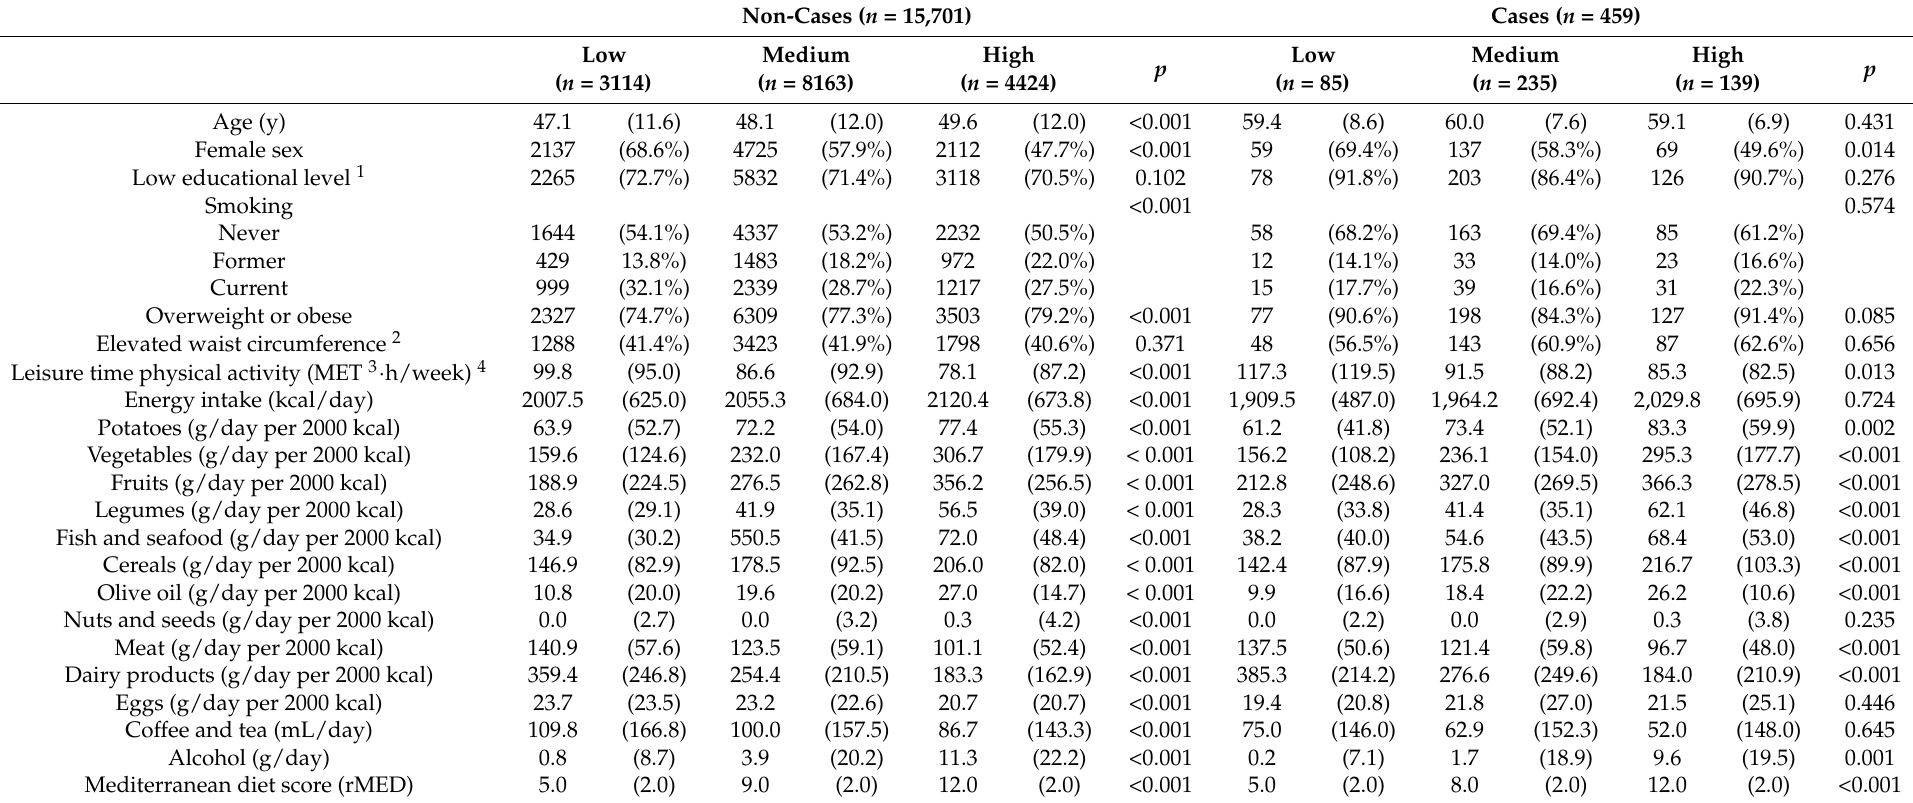
Table 5. Baseline characteristics of dementia cases and non-cases by rMED score group in the EPIC-Spain Dementia Cohort study (N =